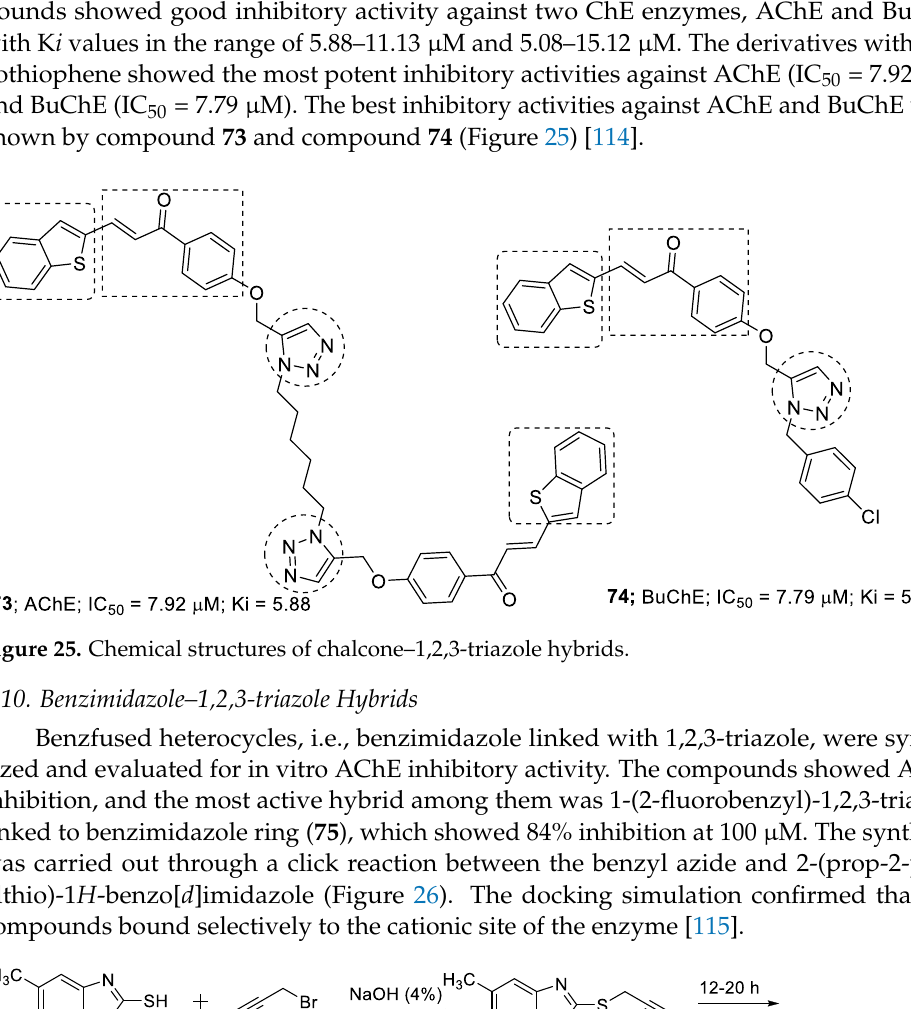
Figure 24. Chemical structures of metalophthalocyanines – 1,2,3-triazole conjugates.